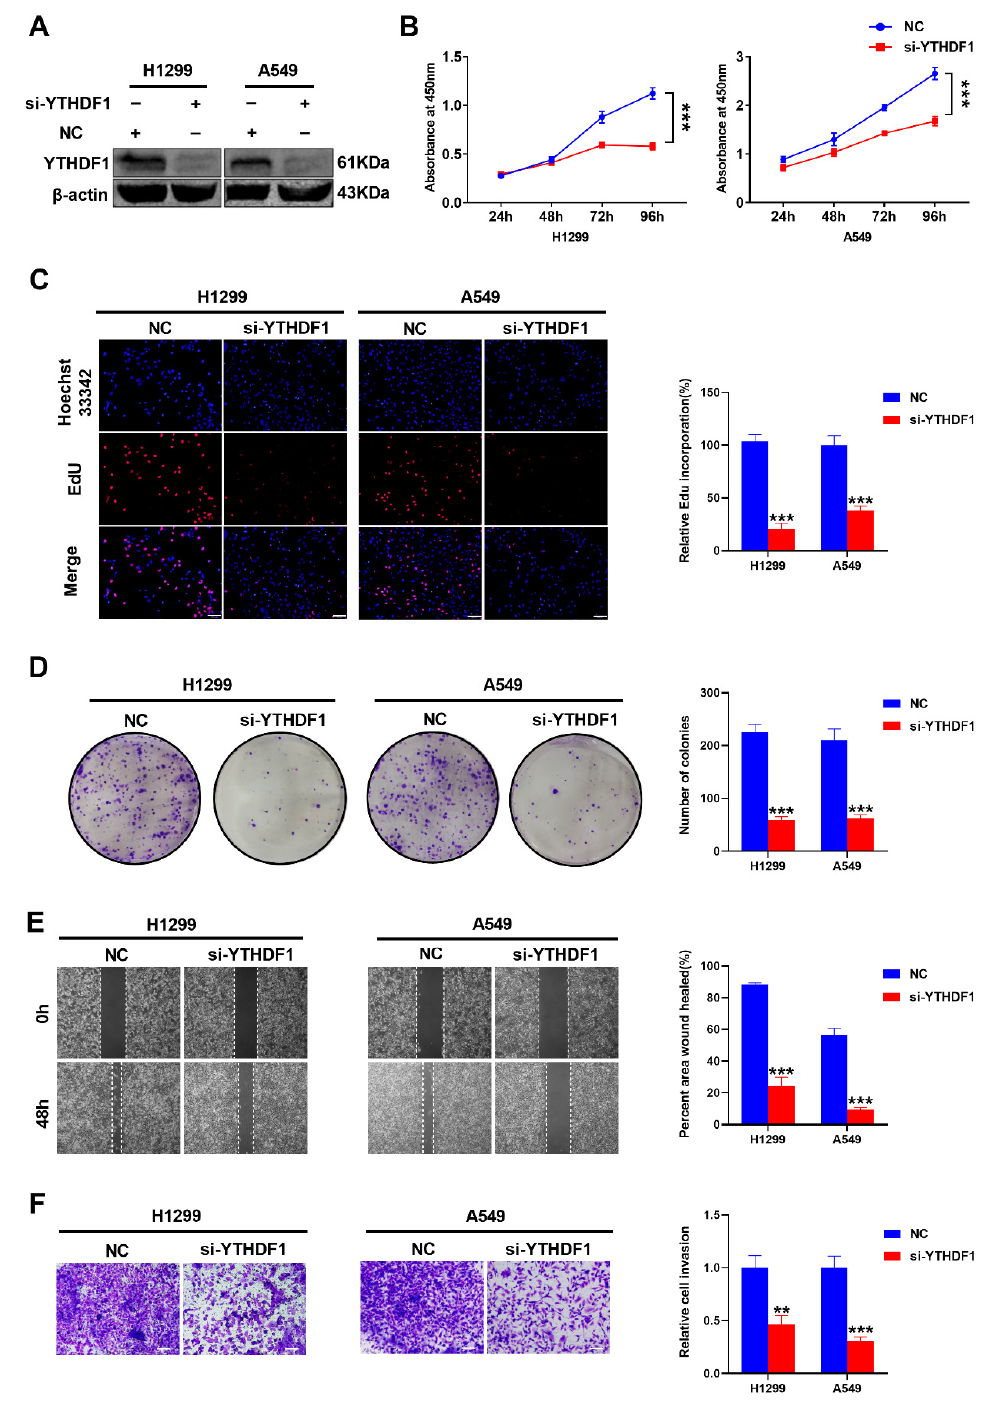
Figure 2. YTHDF1 promotes lung cancer cell proliferation, metastasis and invasion. ( A ) Western blot analysis of transfection with si-YTHDF1 in H1299 and A549 cells. ( B – D ) CCK-8 assays, Edu assays and colony formation assays for H1299 and A549 cells with YTHDF1 knockdown. Scale bar, 100 µ m. ( E , F ) Wound-healing assays and Transwell Matrigel invasion assays for H1299 and A549 cells with YTHDF1 downregulation. Scale bar, 100 μ m. ** P < 0.01 and *** P < 0.001.